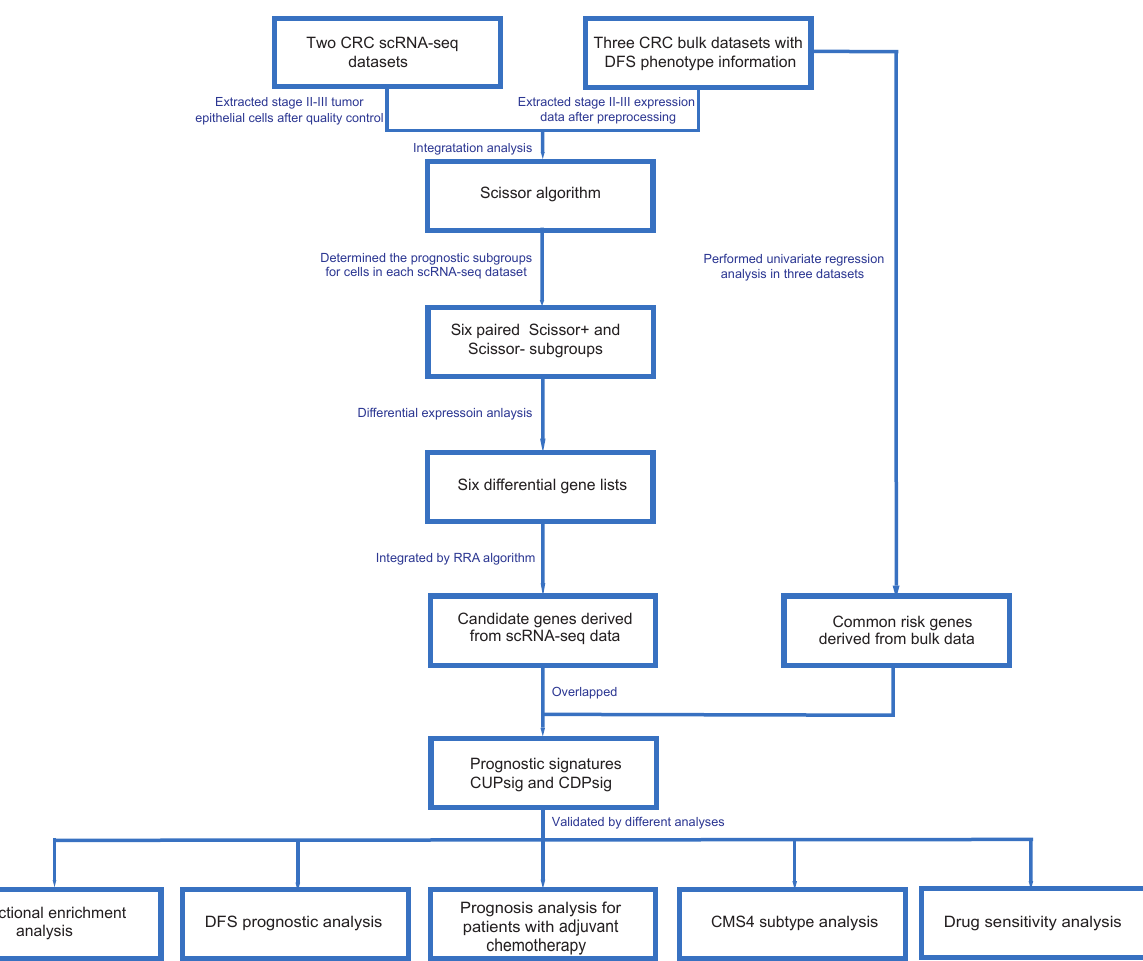
Figure 1. The flowchart for the identification of CRC prognosis-related gene signatures CUPsig and